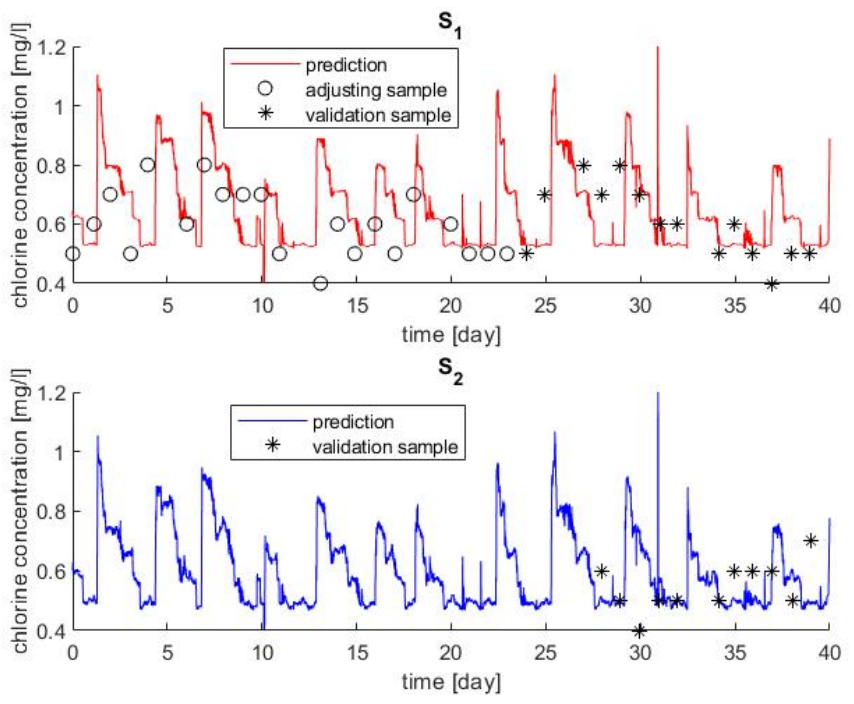
Figure 6. Simulation results for the two sampling points ( S 1 and S 2 ) compared with experimental samplings.